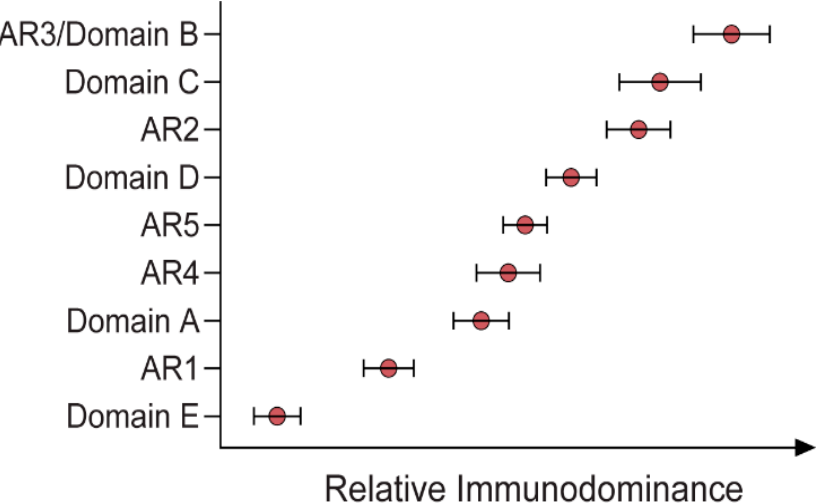
Figure 2. Relative immunodominance of Abs specific to antigenic regions (ARs) 1–5 and domains A–E of a GT1 viral envelope (H77) [30].